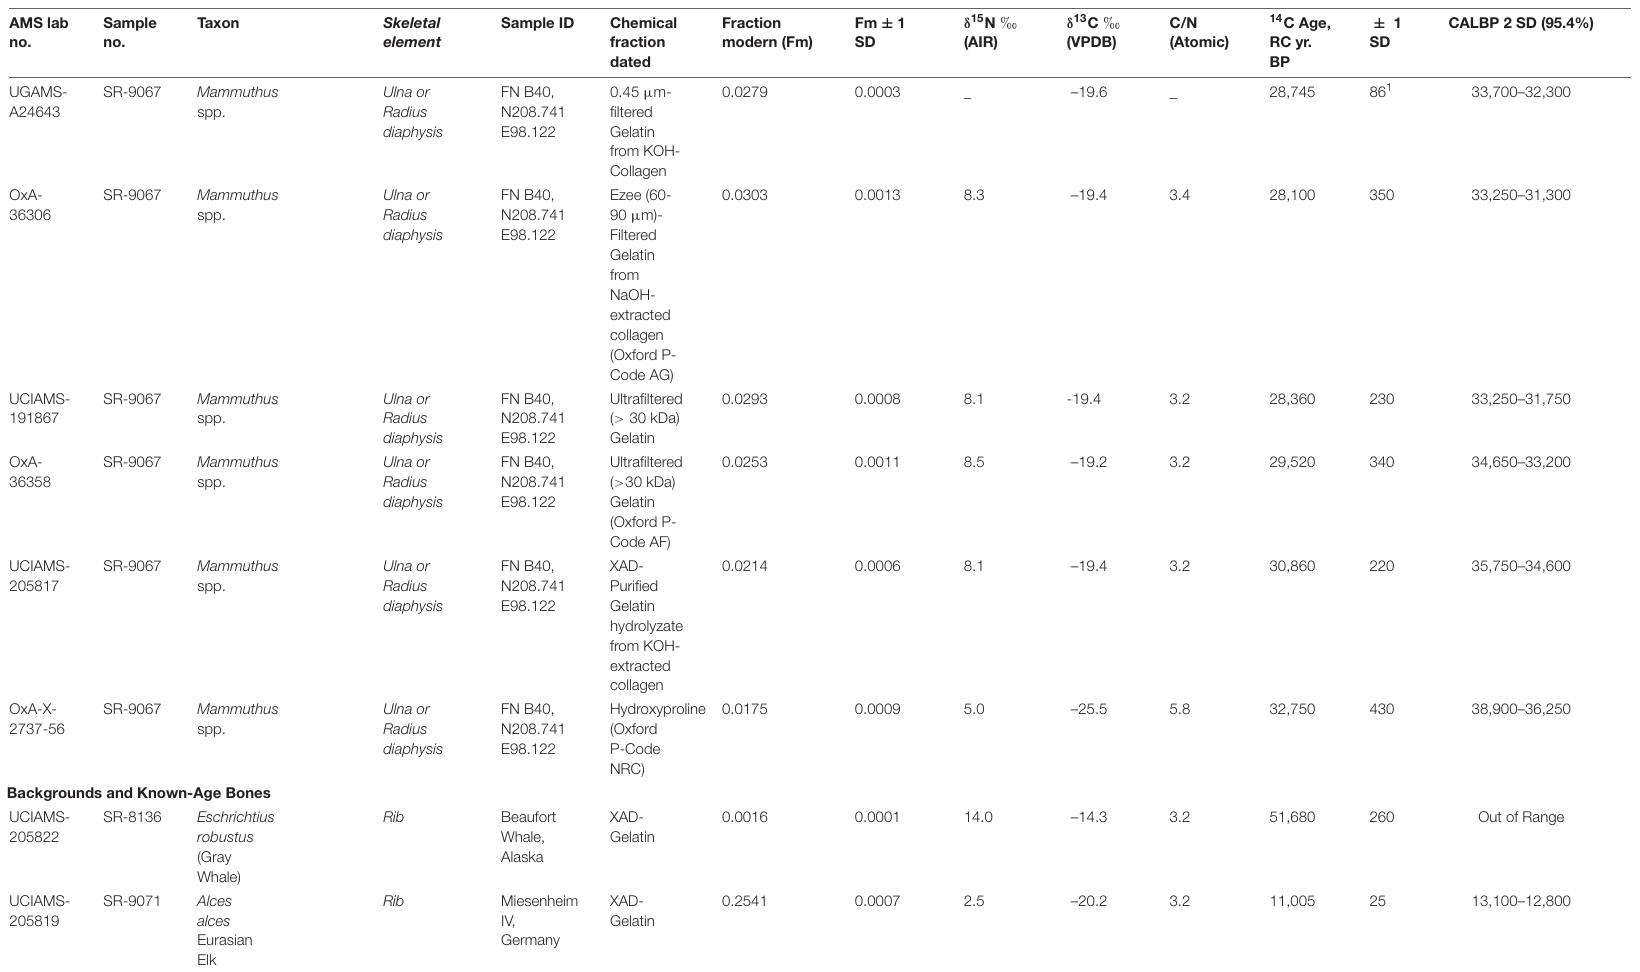
TABLE 1 | AMS 14 C chronometric data for bone collagen from adult Hartley mammoth. AMS lab